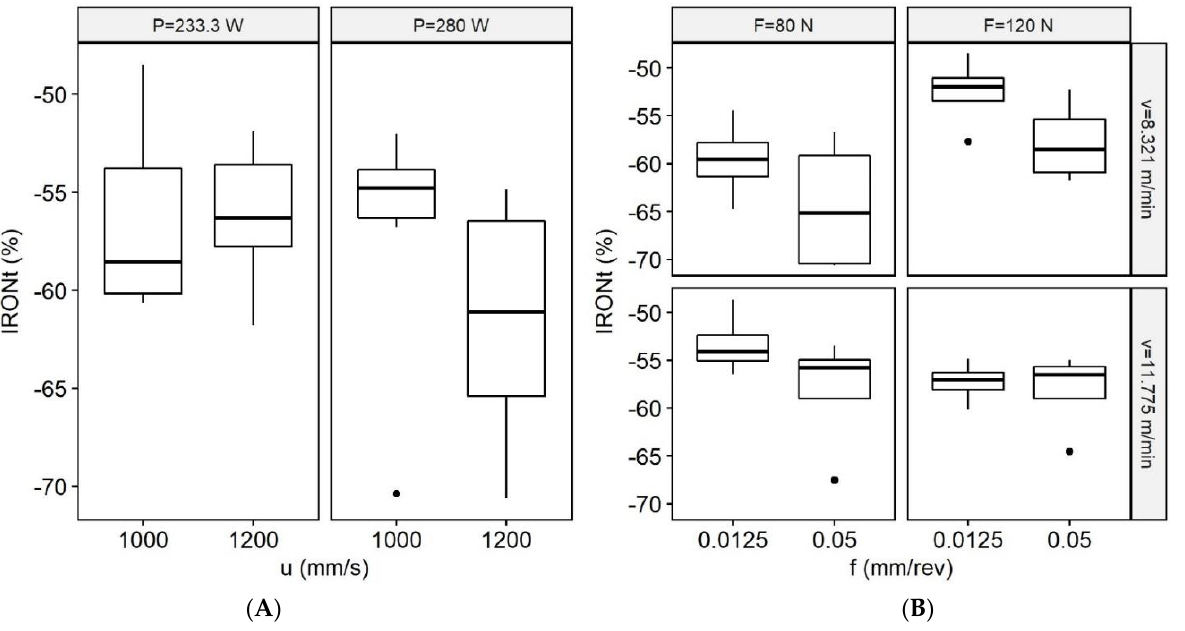
Figure 6. Faceted boxplots of IRONt data, according to experimental factors ( A ) boxes by laser power P and laser scan speed u , ( B ) boxes by burnishing feed f , burnishing speed v , and burnishing force F.